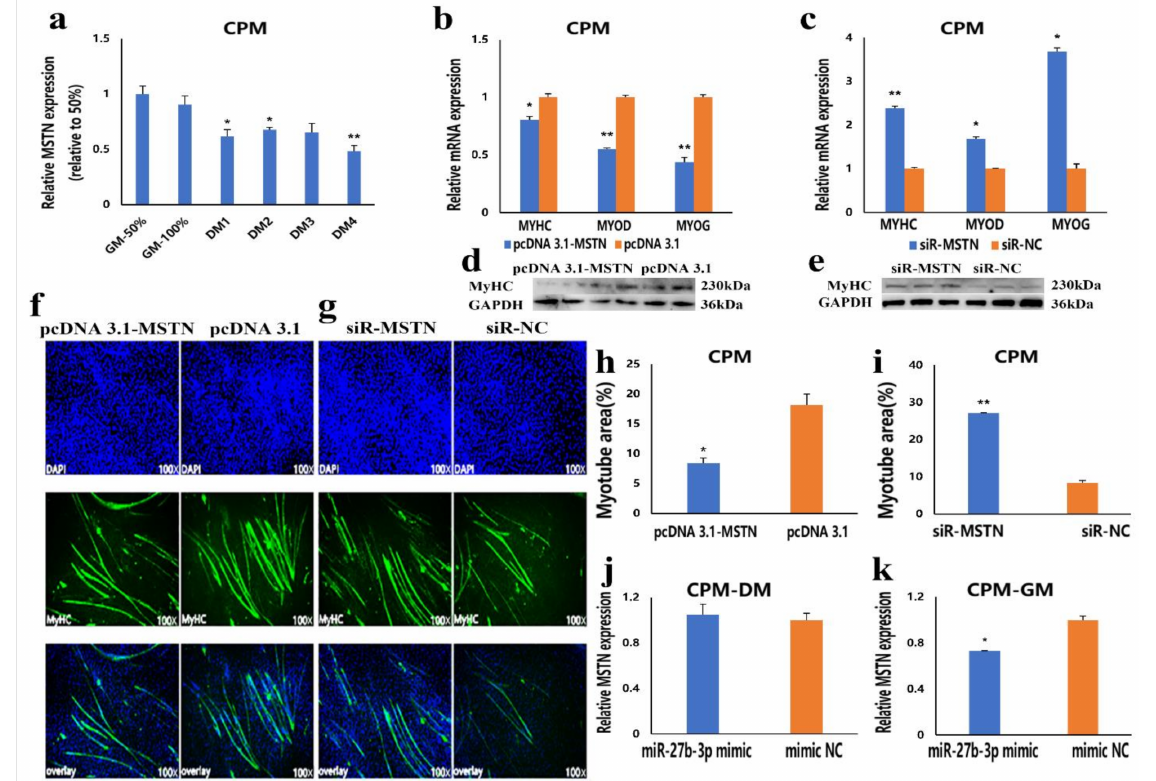
Figure 6. The inhibition of miR-27b-3p on MSTN is different between CPMs proliferation and differentiation. ( a ) The relative expression of MSTN during CPMs’ proliferation and differentiation (GM 50% and GM 100% represent the proliferation density of 50% and 100%; DM1-DM 4 represents differentiation from one to four days. ( b , c ) The mRNA expression levels of differentiation marker genes after transfection with pcDNA 3.1-MSTN and siR-MSTN in CPMs. ( d , e ) The protein expression levels of MyHC after transfection with pcDNA 3.1-MSTN and siR-MSTN in CPMs. ( f , g ) MyHC staining of CPMs at 72 h after transfection with pcDNA 3.1-MSTN and siR-MSTN in CPMs. Microscopic images were obtained by a fluorescence inverted microscope (dmi8, Leica, Germany). ( h , i ) Myotube area (%) of CPMs 72 h after overexpression and inhibition of MSTN . ( j , k ) The proliferating (GM) and differentiating (DM) CPMs were transfected with miR-27b-3p mimic, respectively, and the relative MSTN mRNA expression levels were then analyzed. In all graphs, the results are shown as mean ± SEM (standard error of the mean) ( n = 3). Statistical significance of differences between means was assessed, using the unpaired Student’s t -test (* p < 0.05; ** p < 0.01) vs. NC (negative